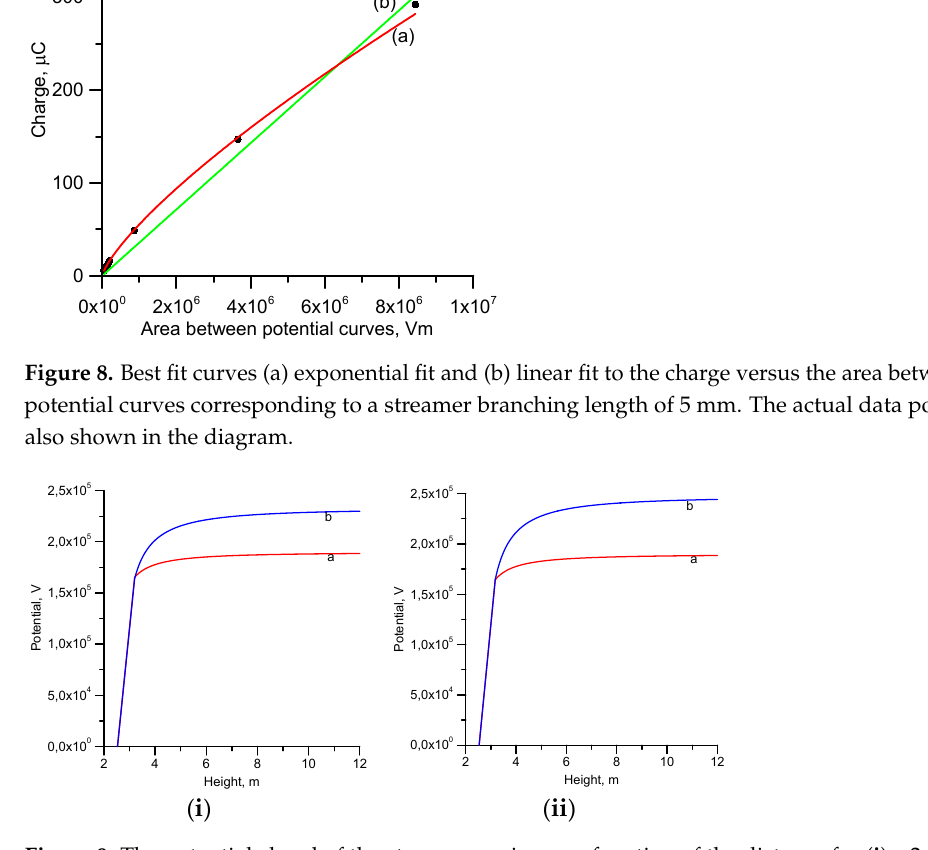
Figure 9. The potential ahead of the streamer region as a function of the distance for ( i ) a 2.5 m rod, 100 kV/m, without branching and ( ii ) a 2.5 m rod, 100 kV/m, with 5 mm branching length. The curve ‘a’ depicts the background potential that existed before the generation of the streamer burst and curve ‘b’ depicts the potential after the creation of the streamer